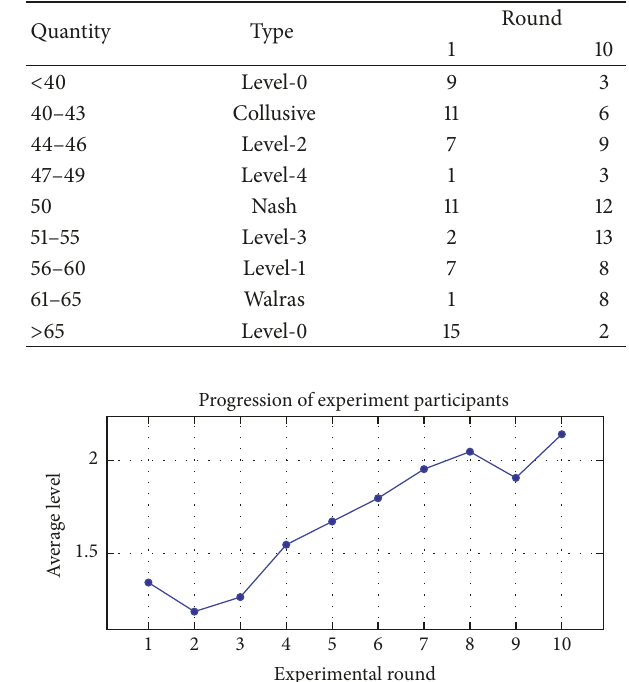
Table 3: This table shows the number of participants who chose a particular extraction quantity in the first period of, respectively, the first and last (10th) repetition (or round) of the experiment. The corresponding levels follow from the analysis in Section 6.